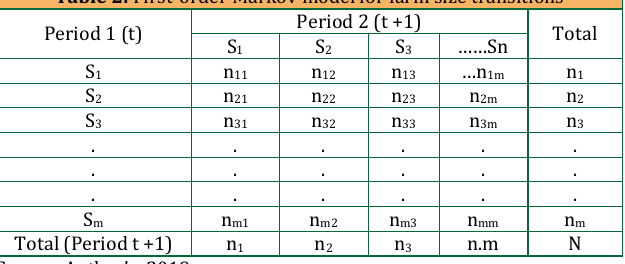
Table 2: First-order Markov model for farm size